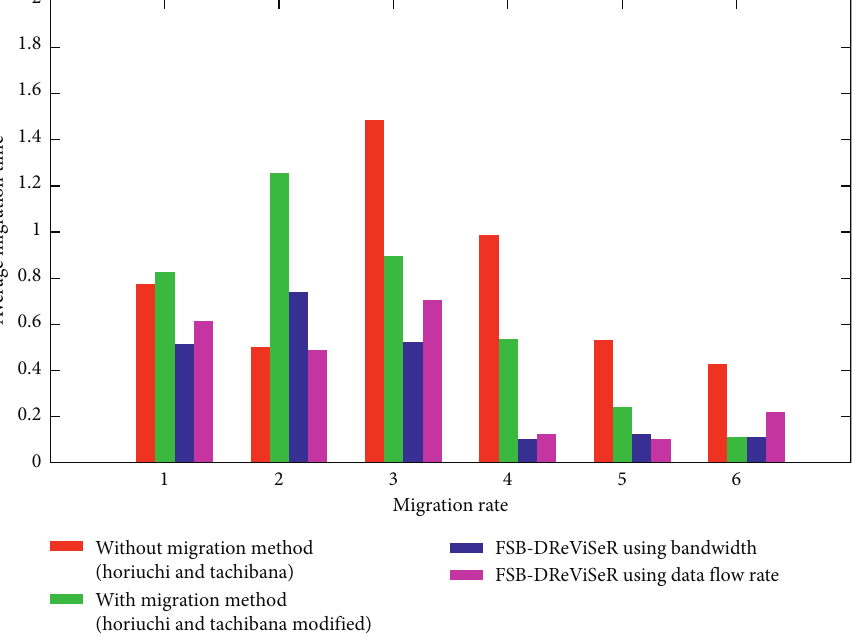
Figure 12: Average migration time versus migration rate for a 20-node figure, the average throughput of each path is considered, and the different replacement times are computed as follows: